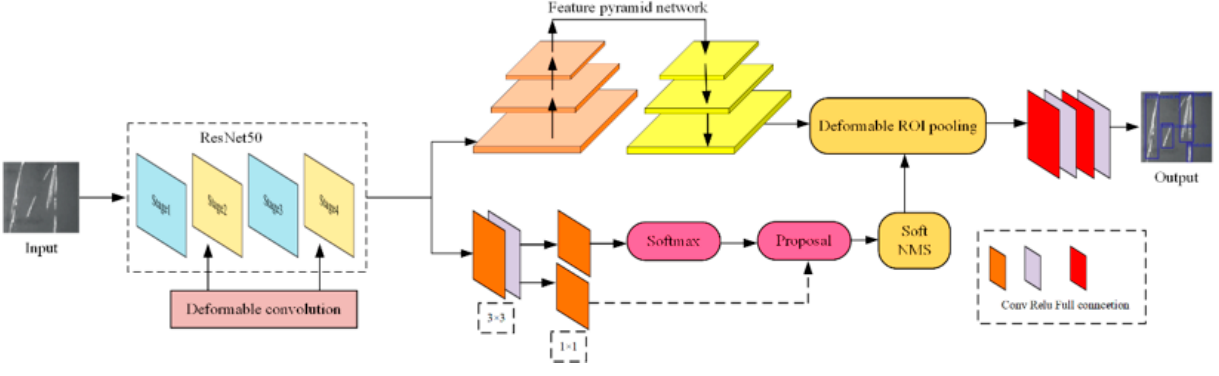
Figure 9. [110] The improved method of Faster R-CNN. Figure 9. The improved method of Faster R-CNN Table 5. Summary of deep learning-based algorithms.